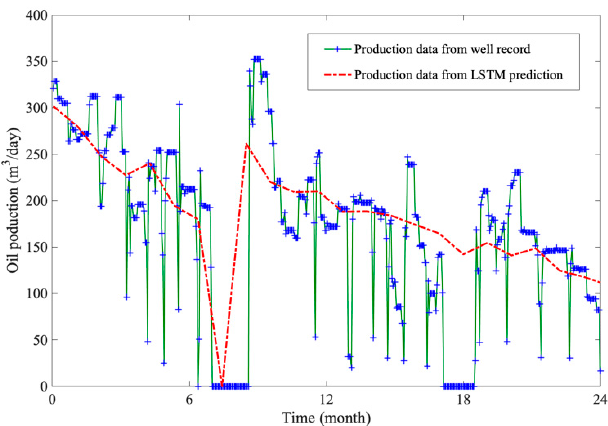
Figure 10. Comparison between actual well record and LSTM prediction in the duration of prediction (101st–148th month in whole time sequence) for oil